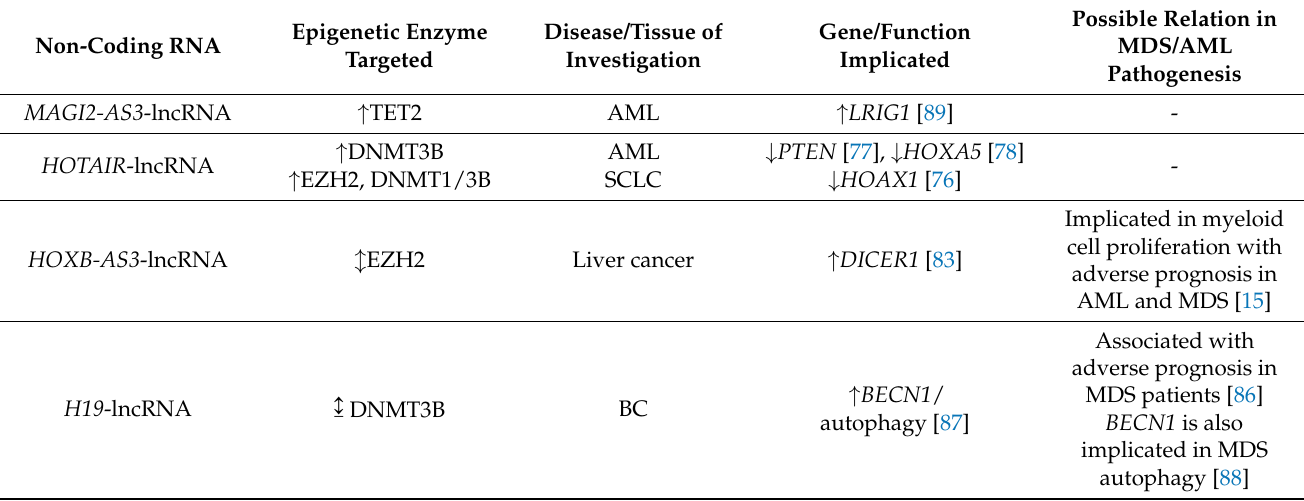
Figure 2. RNAs capable of adopting stem-loop structures exhibit the potential to associate with DNA modifying enzymes depending on RNA secondary structure. The basis of this preferential interaction and targeting of specific CpGs lengthwise genome is the complementarity of DNA-RNA sequences. ( A ). Immature pre-miRNA clusters may bind and provide a scaffold for either DNMTs or TET enzymes to DNA sites for de novo DNA methylation or demethylation events, respectively. DNA hypermethylation prevents transcription, while even partial demethylation promotes transcription albeit at minimal levels (lower). ( B ). DNA sequences occupied by lncRNAs may prevent enzymatic modifications to DNA by obstructing enzymes from binding, which results in an ongoing transcriptional activity. Table 2. Epigenetic enzymes coregulated by lncRNAs and miRNAs and implicated in MDS and AML.